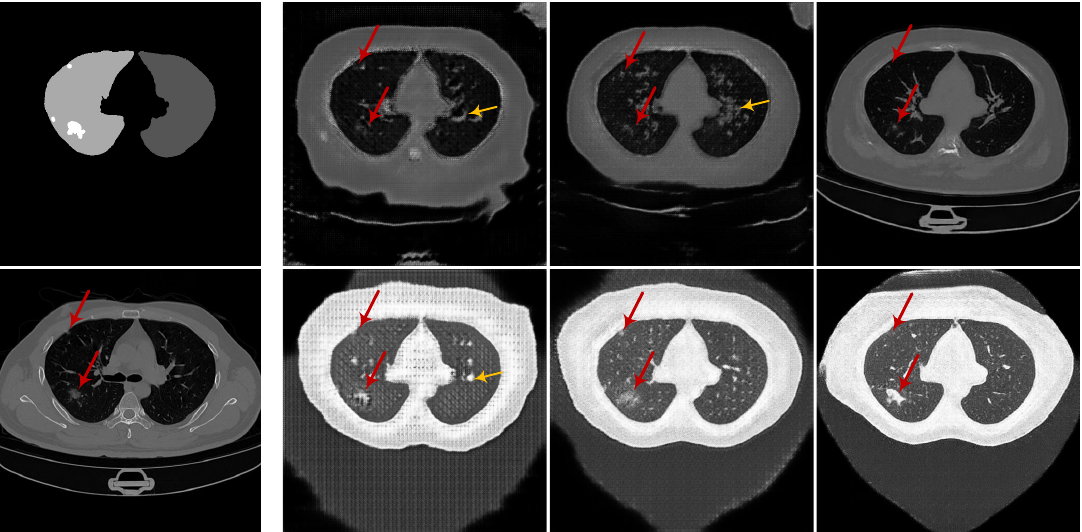
Figure 10. Comparison of synthetic radiological images from different generative models given the same input condition. The input condition and the reference ground-truth radiological image are depicted in the first column. The last three columns are the results of pix2pix, enhanced pix2pix, and CoSinGAN, respectively. Red arrows are used to track and highlight the small infected regions, and yellow arrows are used to indicate the artifacts. The white and gray (e.g., light gray and dark gray) in condition masks represent the infected regions and lungs,